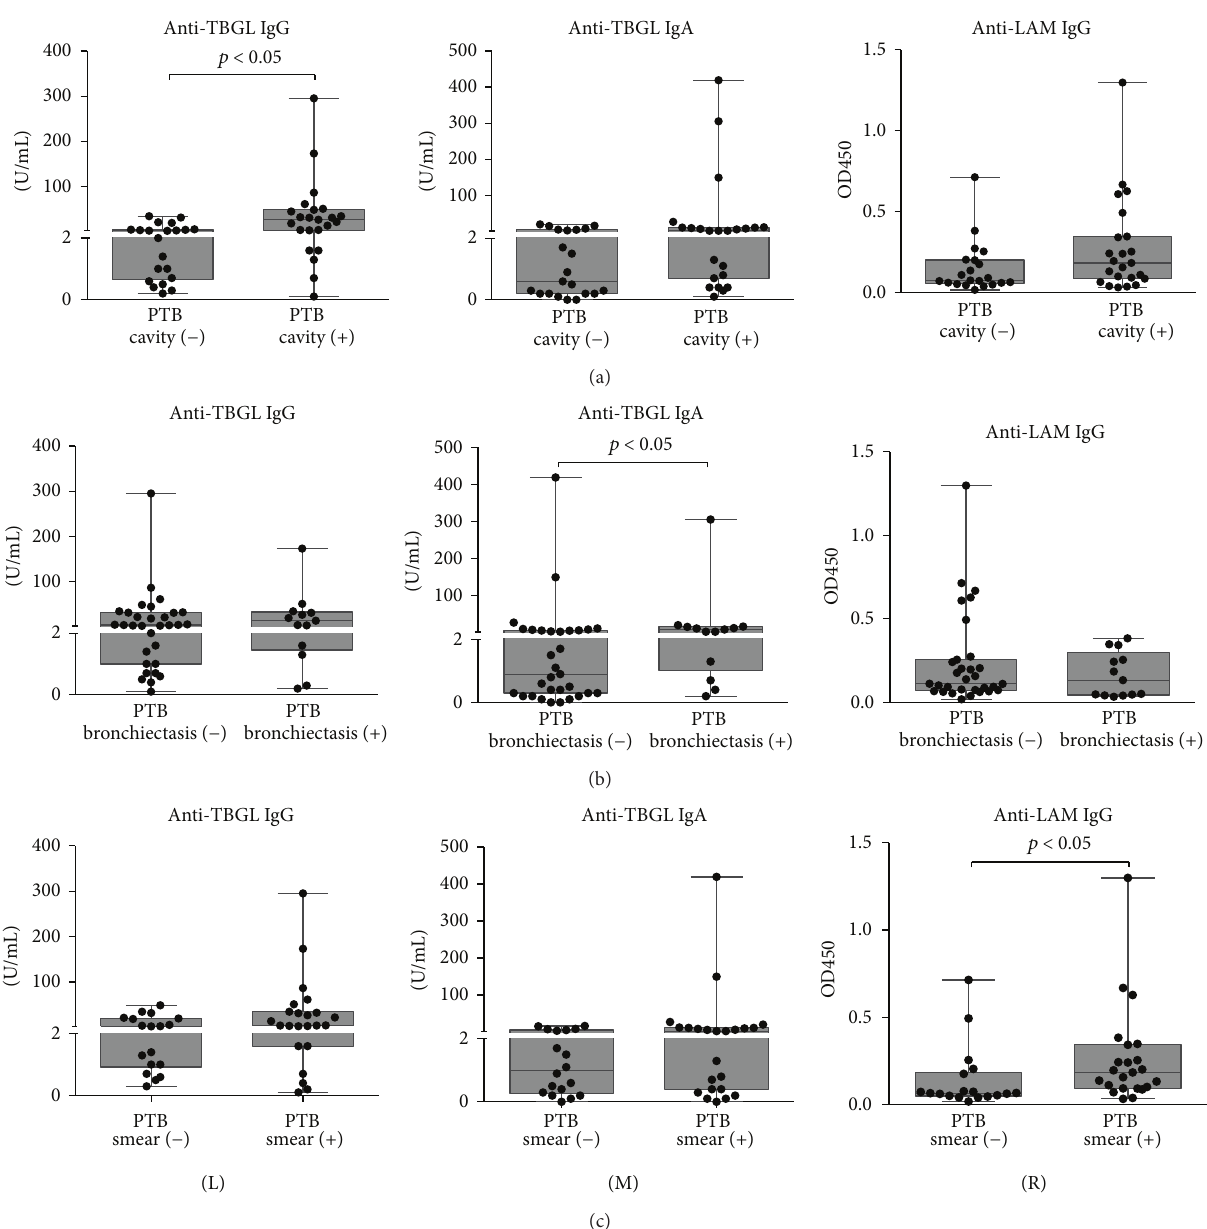
Figure 2: Elevated titers in association with different clinical findings. (a), (b), and (c) display findings of PTB-cavity versus PTB-noncavity, PTB-bronchiectasis versus PTB-nonbronchiectasis, and PTB-smear-negative versus PTB-smear-positive, respectively. A 𝑝 value less than 0.05 indicates a significant difference between 2 groups by nonparametric 𝑡 -test. (L), (M), and (R) referred to anti-TBGL IgG, anti-TBGL IgA, and anti-LAM IgG,